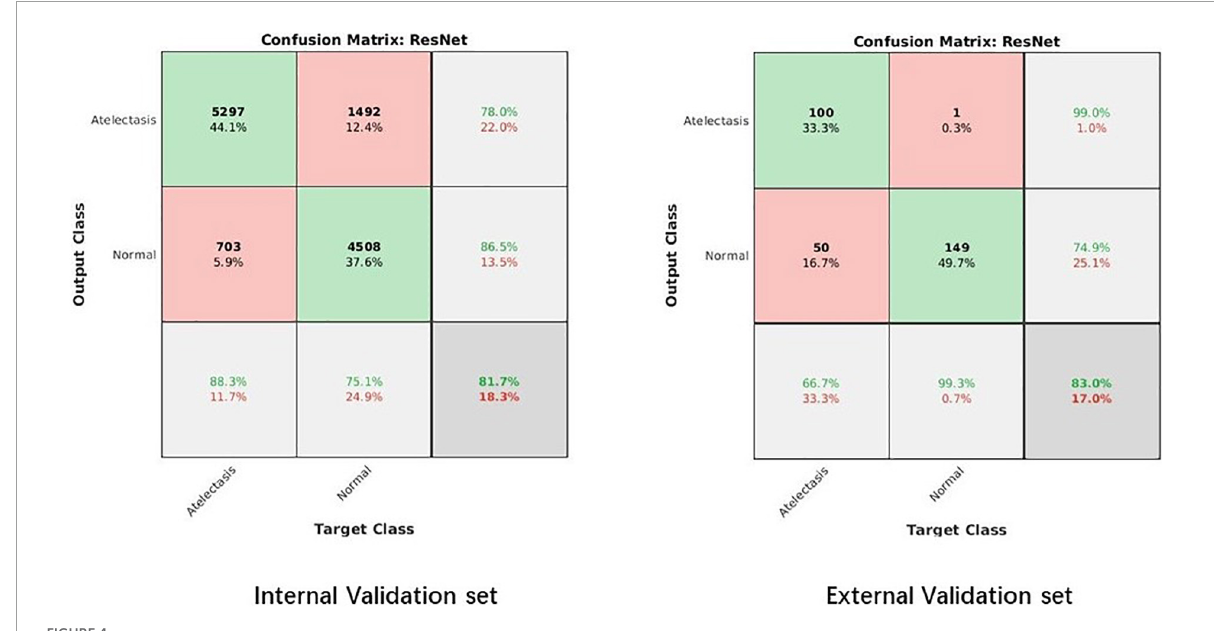
FIGURE4 The confusion matrix of the internal and external validation sets.